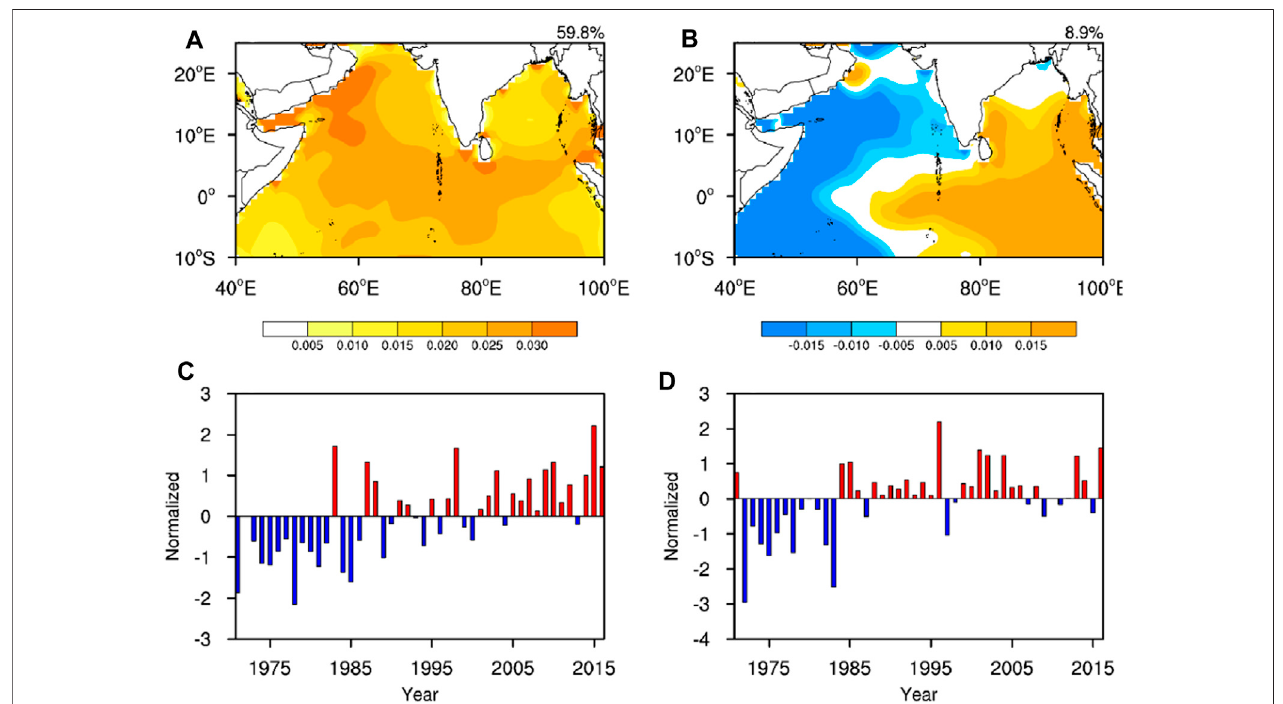
FIGURE 2 | The fi rst two leading EOF modes of summer SST anomalies in tropical IO during 1971 – 2016 in (A) and (B) . The normalized principal component (PC) corresponding to the leading mode of EOF1 (C) and EOF2 (D) .